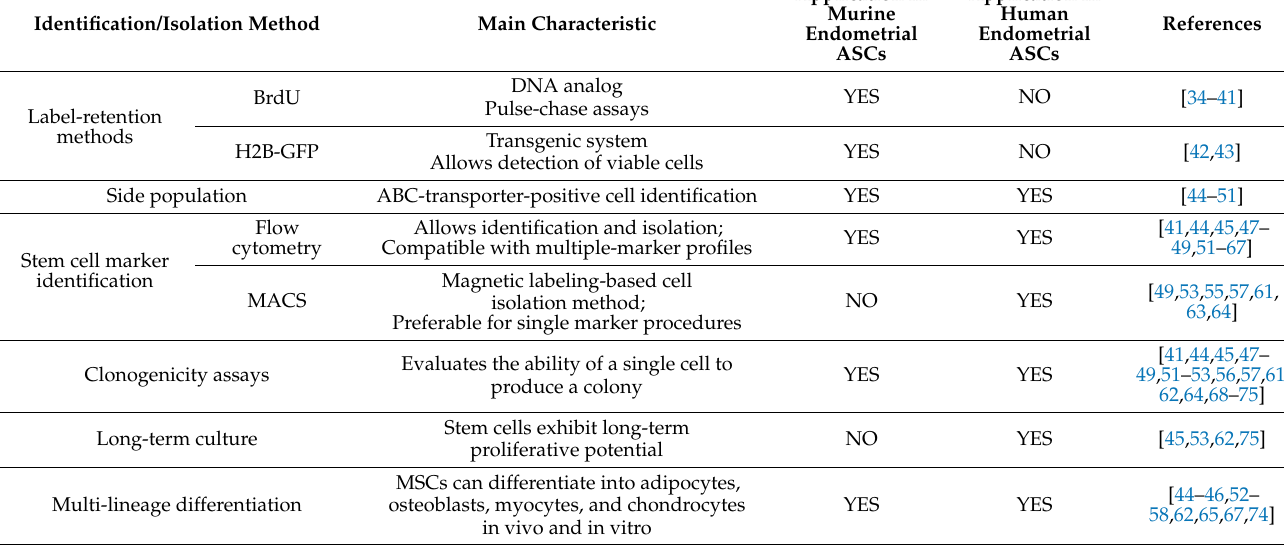
Table 1. Endometrial stem cell identification and isolation techniques in human and murine models. All procedures reviewed in the text are summarized and